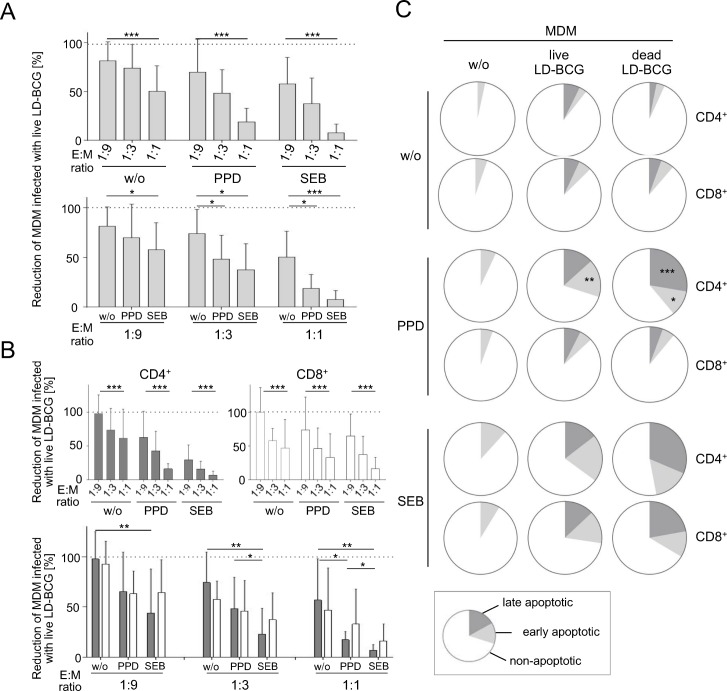
Cytotoxic effects of total effector T cells and T-cell subpopulations against LD-BCG infected MDM and markers of induced cell death on MDM.Combined analyses of autologues E/M samples from healthy donors (n = 8) for (A), (n = 6) for (B), and (n = 5) for (C) are shown. Total effector T cells (A) or enriched CD4+/CD8+ T-cell subpopulations (B, C) were applied. (A, B) Cytotoxicity of differentially stimulated effector T cells against MDM infected with LD-BCG was assessed by flow cytometry. Different E/M ratios were applied (x-axes) and absolute numbers of MDM infected with live LD-BCG are indicated (y-axes). Mean and standard deviations are shown. (C) Apoptosis marker expression on MDM with or w/o LD-BCG infection after coculture with differentially stimulated CD4+ or CD8+ effector T cells. E:M ratios of 1:3 are shown. The proportions of non-apoptotic (open), early apoptotic (bright grey), and late apoptotic (dark grey) MDM are depicted as pie charts. Non-infected MDM (left panel) as well as MDM infected with live (middle) and dead (left) LD-BCG are shown. Median values of five independent experiments are depicted. The Mann-Whitney U-test were applied. Asterisks indicate significant differences (***: p<0.001; **: p<0.01; *: p<0.05).